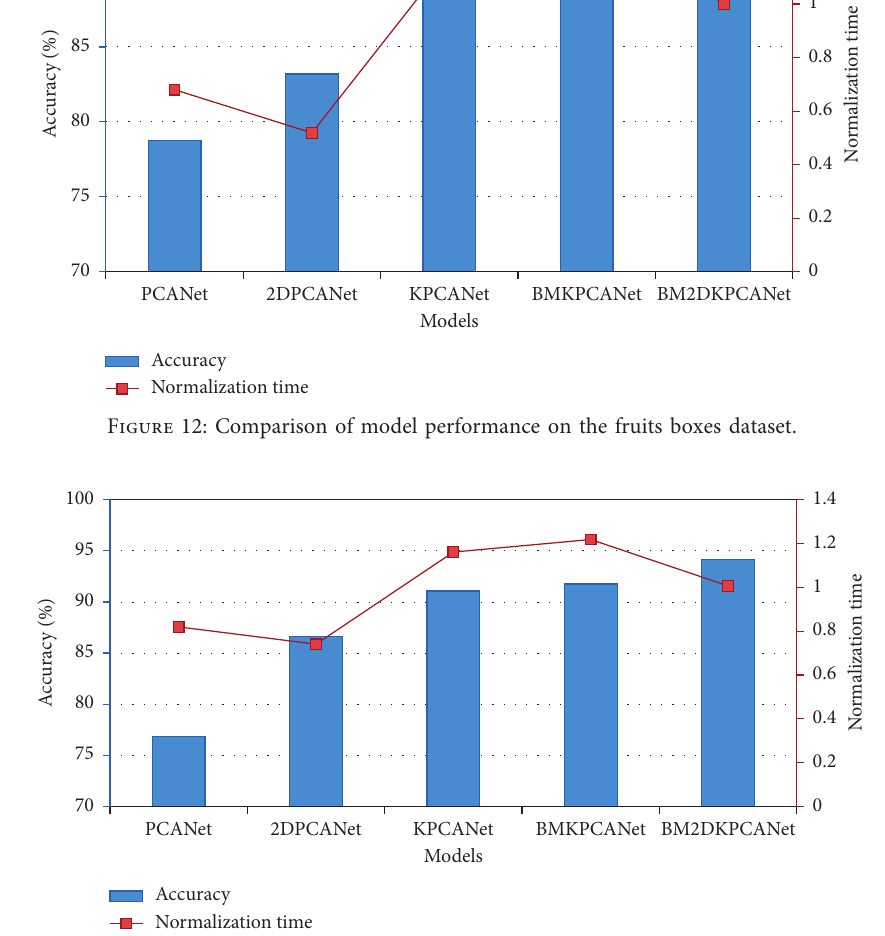
Figure 13: Comparison of model performance on the ETH-80 dataset.